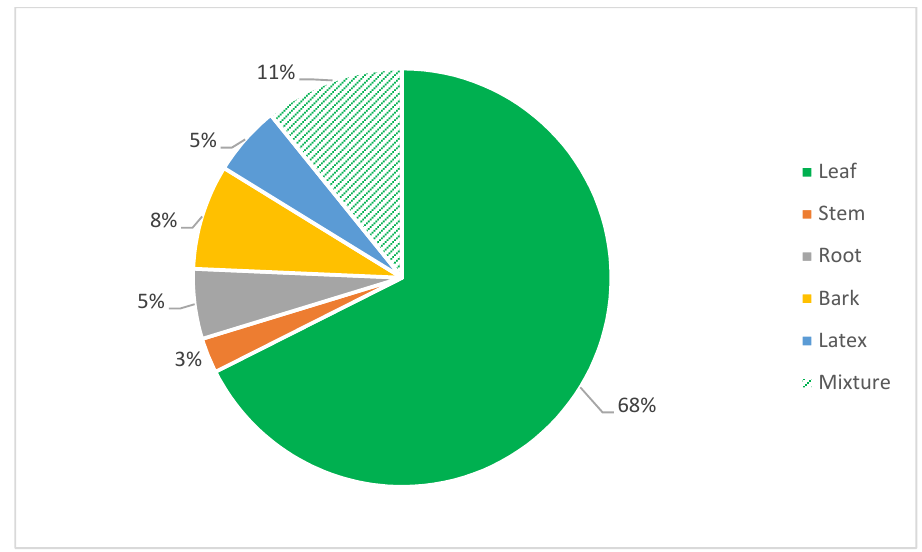
Figure 4. Graphic representation of plant parts frequently used for treatment. Table 3. Method of use of the forest medicinal plants.